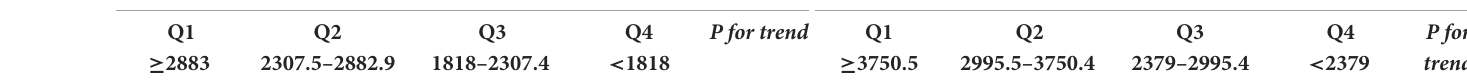
TABLE 3.4 Associations of FEV1 and FVC with all–cause mortality in U.S. adults aged at least 20 years among different